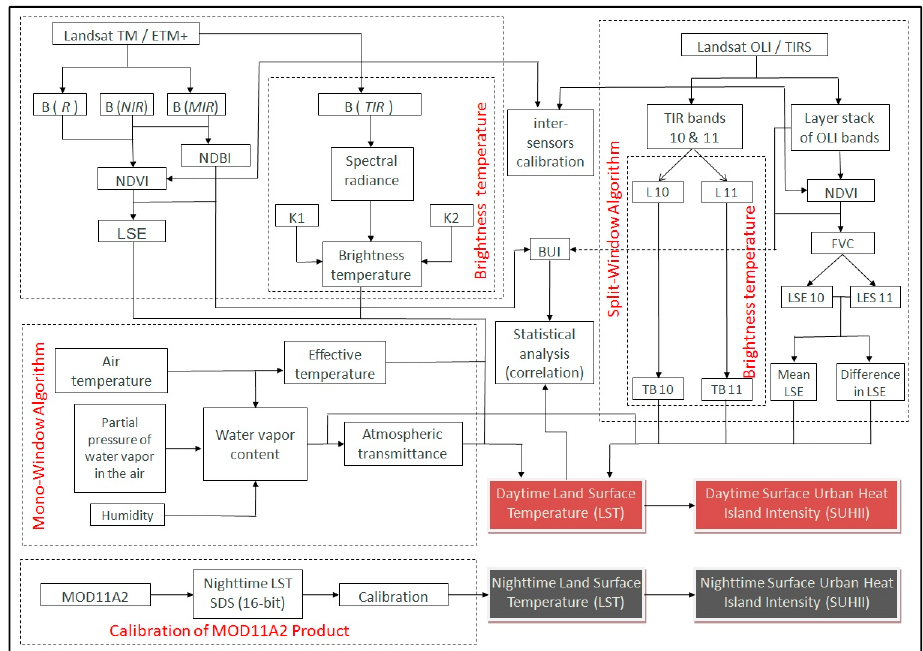
Figure 2. Flowchart of methodology (NDVI: normalized difference vegetation index; NDBI: normalized difference built-up index; K1 and K2: calibration constants; LSE: land surface emissivity; BUI: built up index; Li: spectral radiance of band I; FVC: fraction vegetation cover; TB: brightness temperature).